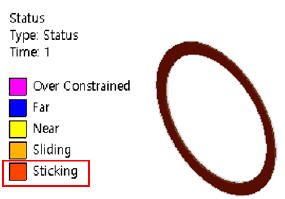
Figure 19. Contact status between stainless and graphite layers.